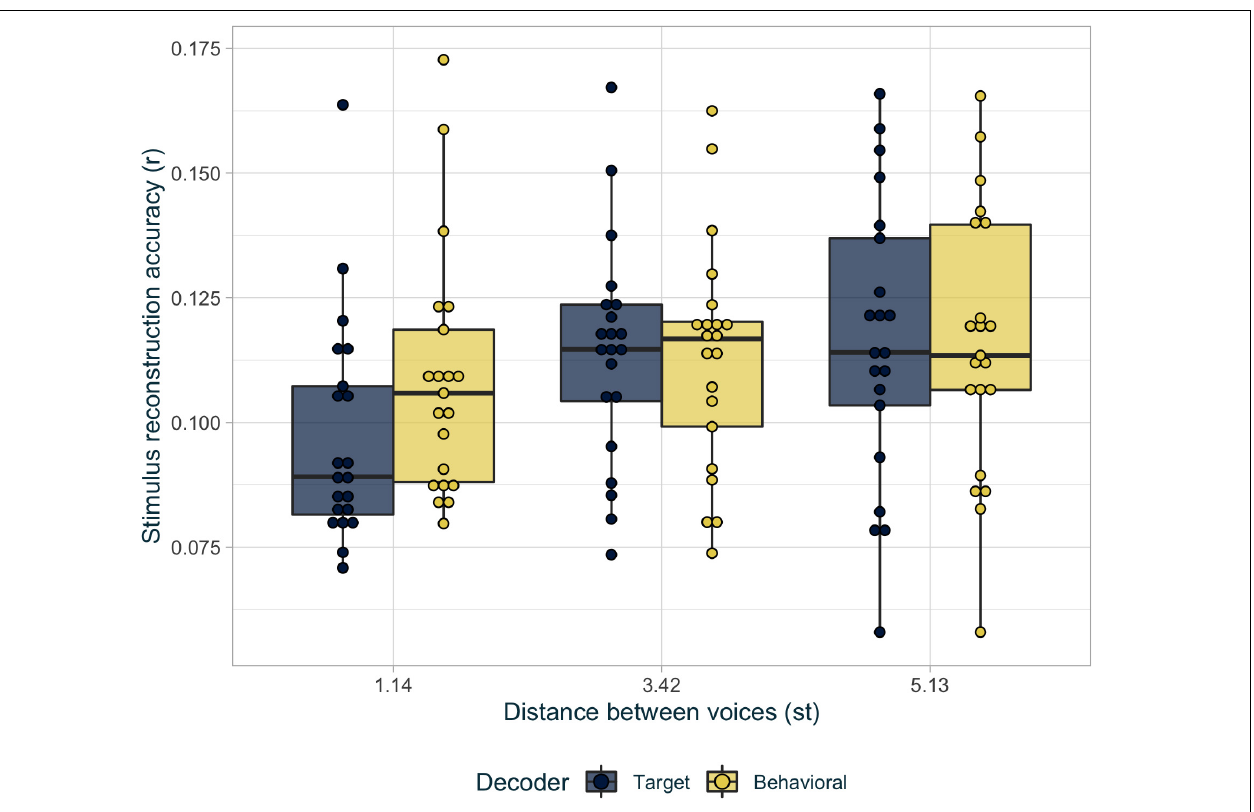
FIGURE 5 | Average reconstruction accuracy r per condition for the decoder based on original target stimuli (in dark blue), and for the decoder based on the best inferred stimuli (in light yellow).